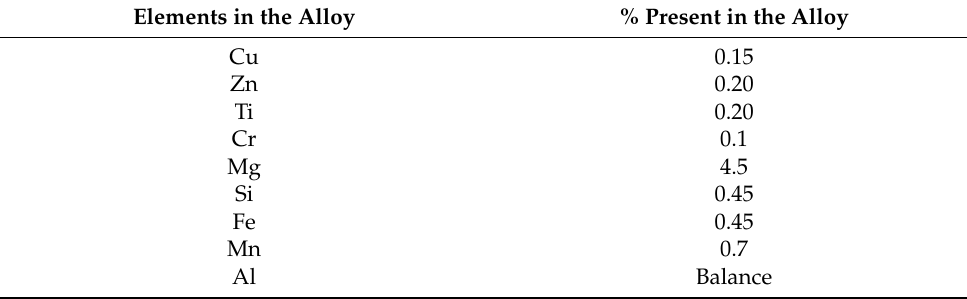
Table 1. Composition specification of the AA 5083 alloy in wt.% of elements.